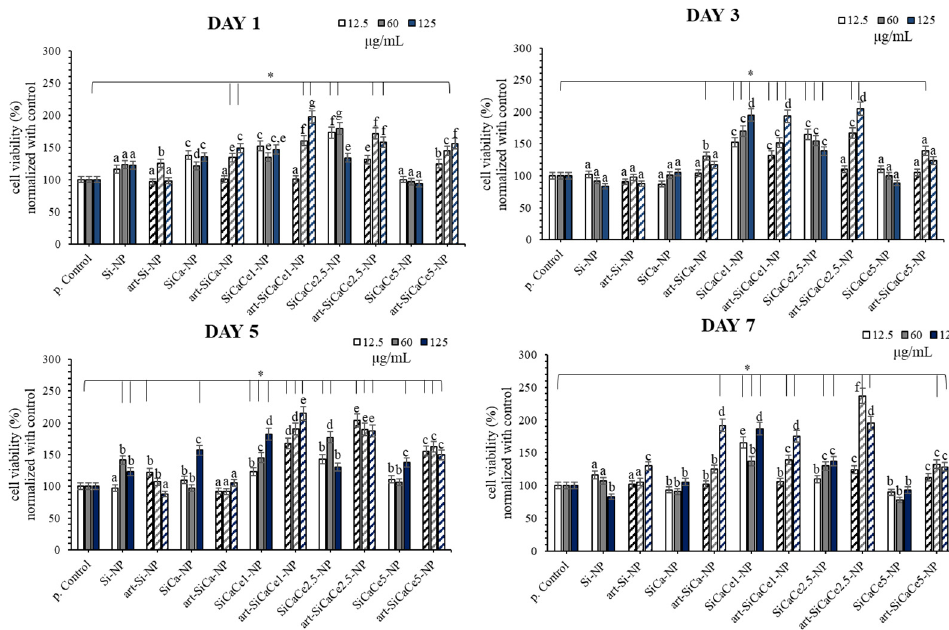
Figure 8. MTT results of cell viability at different concentrations of nanopowders (NPs) ( µ g/mL). The lines with * above bars indicate statistically significant differences ( p < 0.05) of cell viability among the treated cells with the different NPs and concentrations and the untreated cells (controls), while different letters above bars suggest statistically significant differences ( p < 0.05) of cell viability among the cells treated with different concentrations of NPs. Same letters above the bars suggest that cell viability did not differ significantly among the specific NPs and associated concentrations.